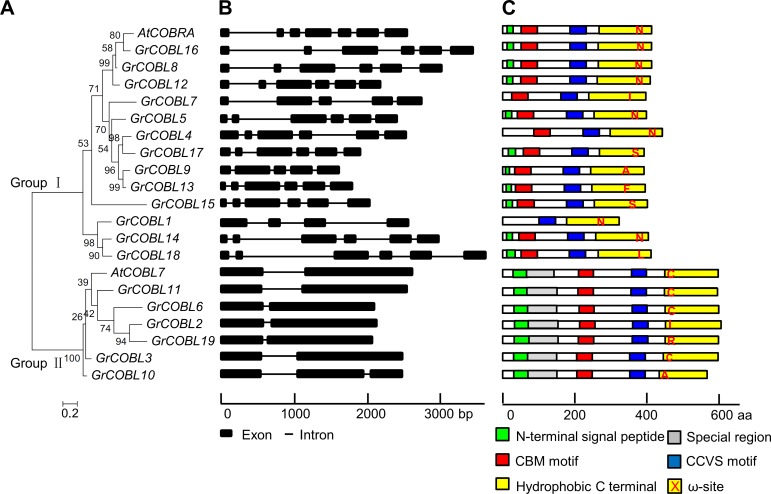
Phylogenetic relationship, gene structure and motif compositions of the COBLs in G. raimondii and AtCOBRA, AtCOBL7 in A. thaliana.A. The phylogenetic tree was conducted using MEGA 5.0 software with the maximum likelihood method. B. Exon/intron organization of GrCOBL members. Black boxes and black lines represented the exons and introns. The length of nucleotides was shown below. C. Schematic representation of the conserved motifs of GrCOBL proteins elucidated by MEME and SMART. Each motif was marked by the different colors and the ω-sites were showed in red font. The length of amino acids was shown below.